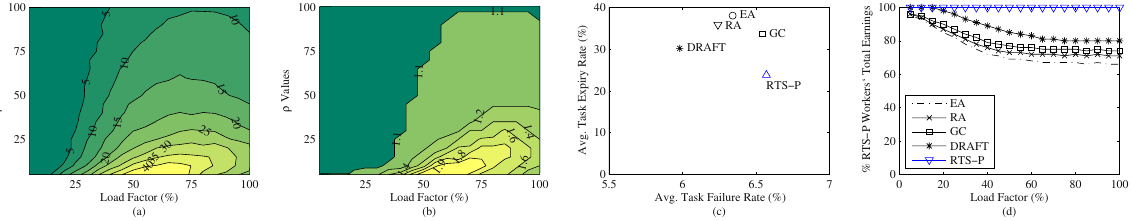
Figure 5. Experimental results under the worker behaviour characteristic setting = − μ R h : ( a ) The percentage of all tasks successfully sub-delegated by RTS-P agents; ( b ) The average sub-delegation chain length; ( c ) The average task expiry rates vs. the average task failure rates; ( d ) The total income as a percentage of the total income of RTS-P